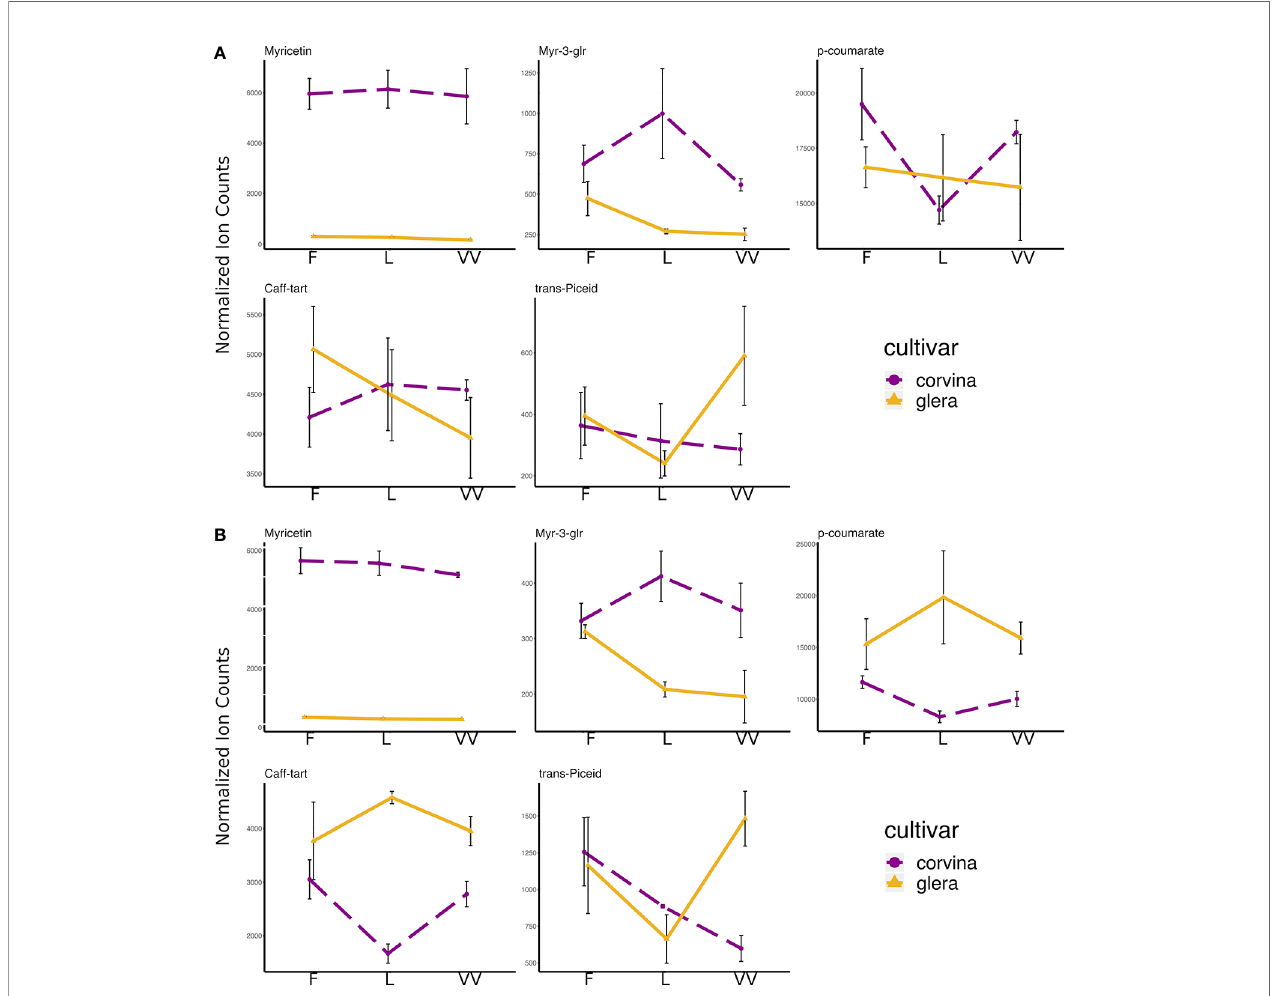
FIGURE 4 | Signi fi cant metabolites modulated by Genotype × Environment interactions in Glera and Corvina. Levels represent relative abundance based on ion counts. Purple lines represent Corvina variety, and yellow lines represent Glera variety. (A) G×E interactions at complete-ve ́ raison (CV) stage; (B) G×E interaction at ripening (R) stage. Error bars indicate standard error (n =